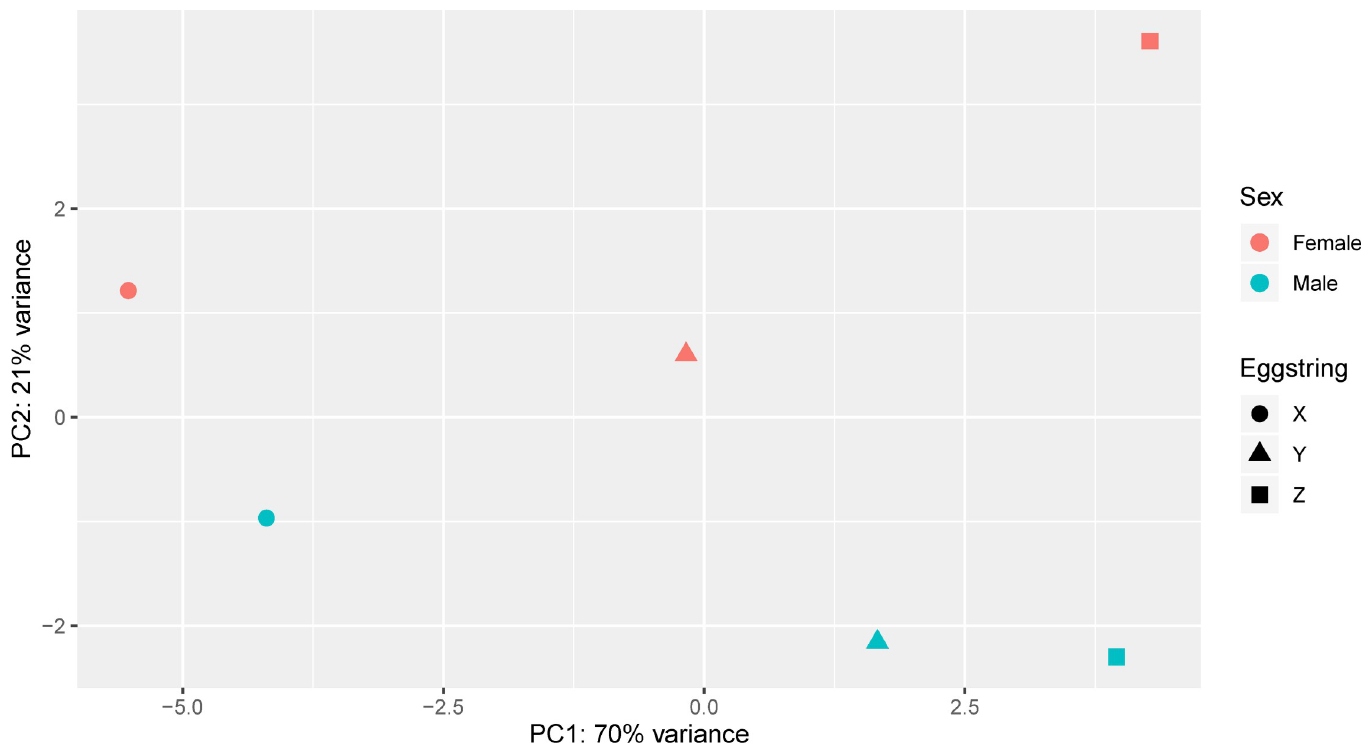
Fig 3. Principal component analysis of the general gene expression in female and male nauplius II L . salmonis samples. Animals from three different egg strings (X, Y, Z) were sampled in the nauplius II stage, and the sex of the individual animals was determined by qPCR. Males and females from each egg string were pooled together, respectively. RNA was isolated and employed in